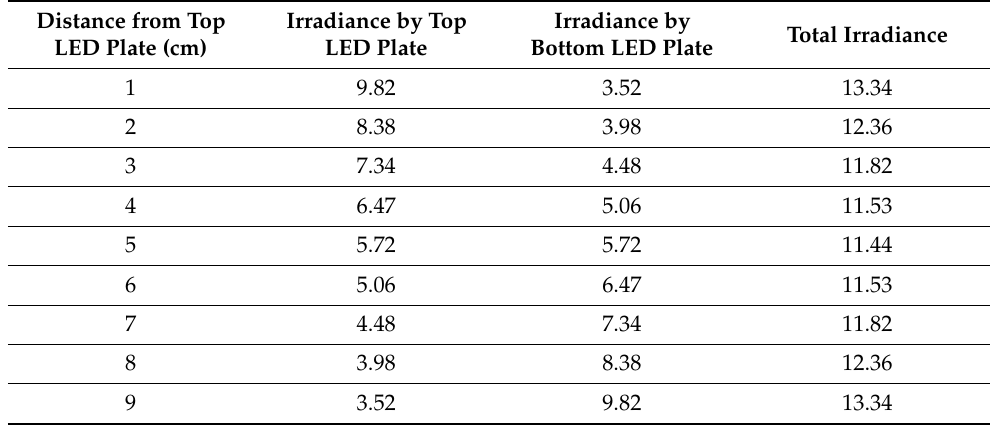
Total Irradiance